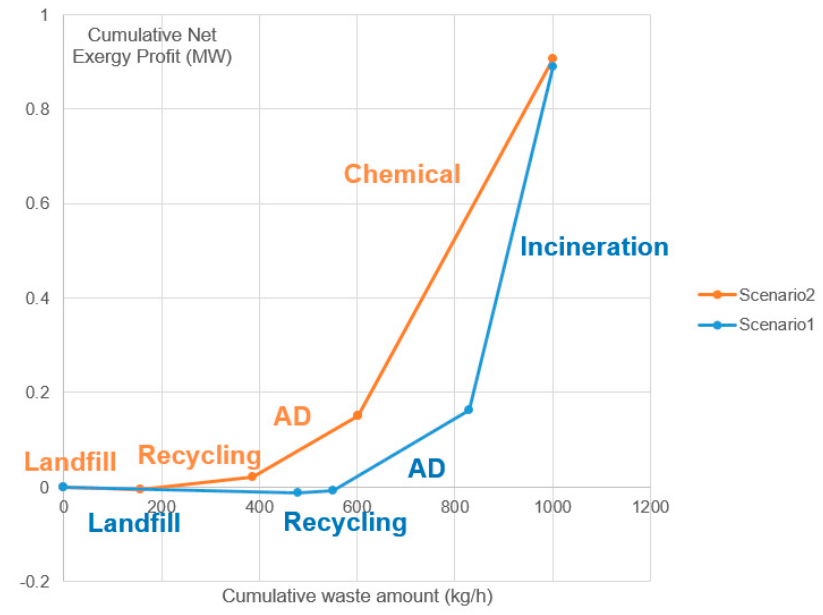
Figure 12. Composite Curves for the exergy profit of the MSW treatment under comparison.